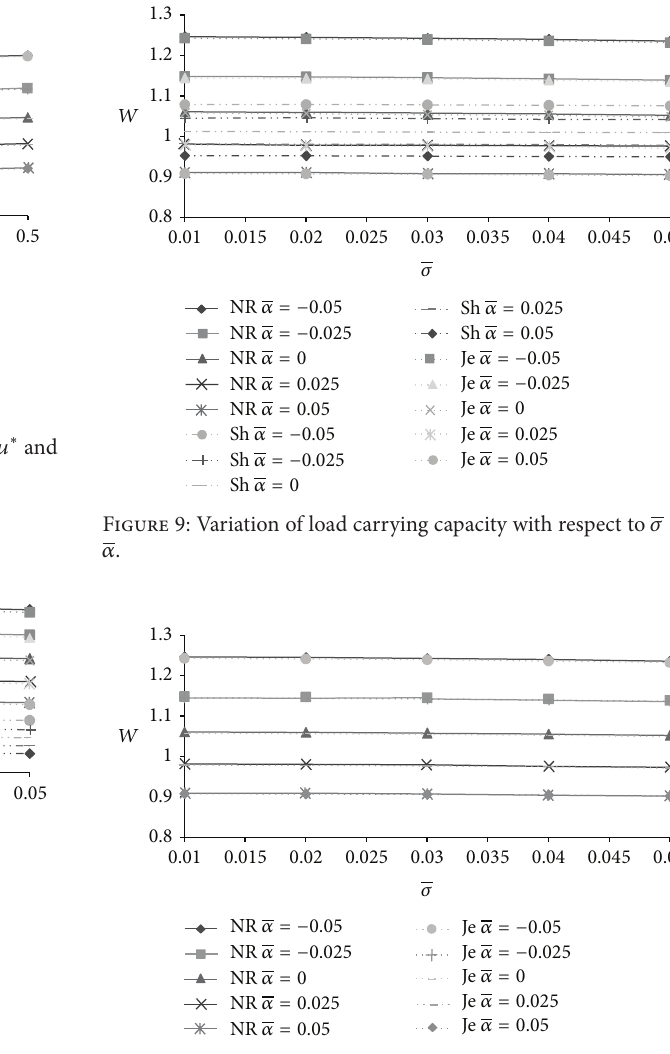
Figure 10: Variation of load carrying capacity with respect to 𝜎 and 𝛼